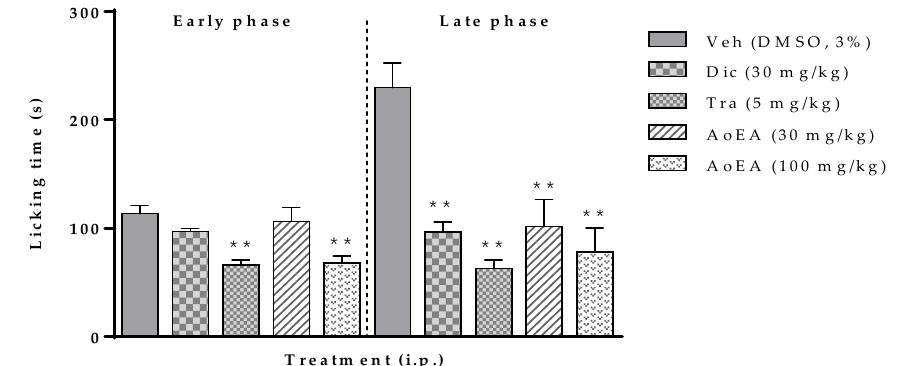
Figure 1. Effect of the ethyl acetate extract of Aristolochia odoratissima (AoEA, 30 and 100 mg/kg, i.p.) in the formalin test (2.5%, 25 µL/paw) in mice. The data are expressed with the mean ± sem. One-way ANOVA + Dunnett test, * p < 0.05 and ** p < 0.001. Veh: Vehicle; Dic: Diclofenac, Tra: Tramadol.